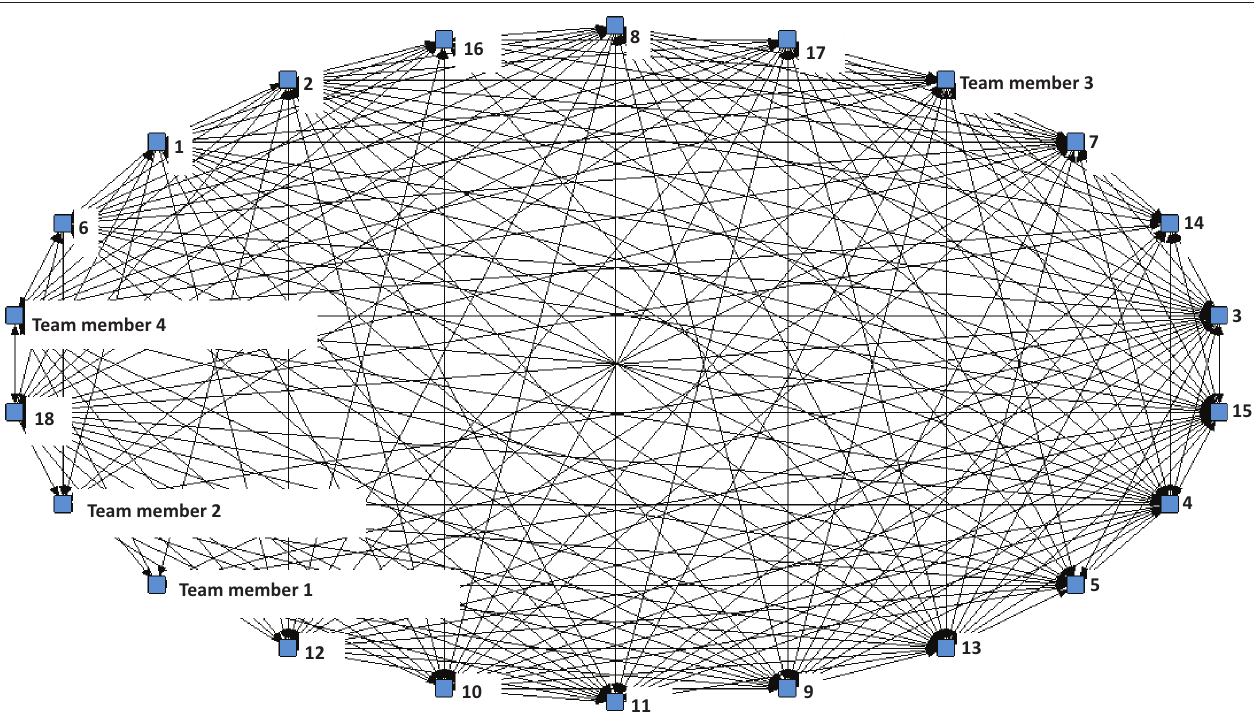
FIGURE 2: Organisational network analysis pre-test graph for frequency of giving information, low frequency